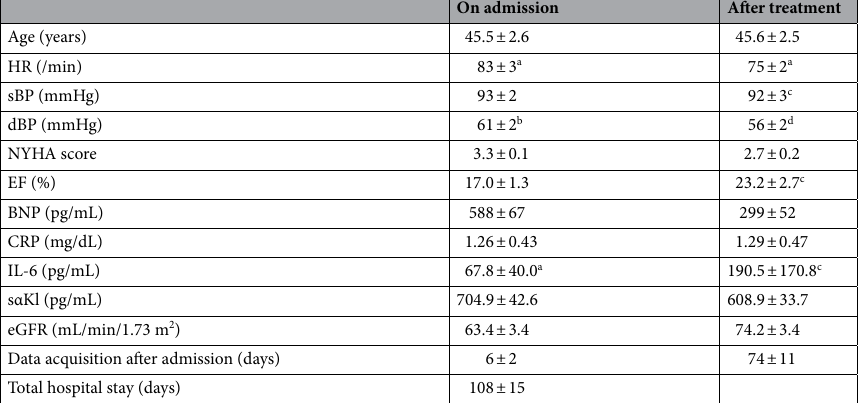
Table 1. Characteristics of patients with heart failure. Patient characteristics were obtained on admission and after treatment (n = 28). Data are expressed as mean ± sem. Diagnosis: dilated cardiomyopathy n = 18, dilated hypertrophic cardiomyopathy n = 3, ischemic cardiomyopathy n = 3, fulminant myocarditis n = 3, hypertensive heart disease n = 1. Comorbidity: anemia n = 3, atrial fibrillation n = 4, dyslipidemia n = 7, diabetes n = 7,